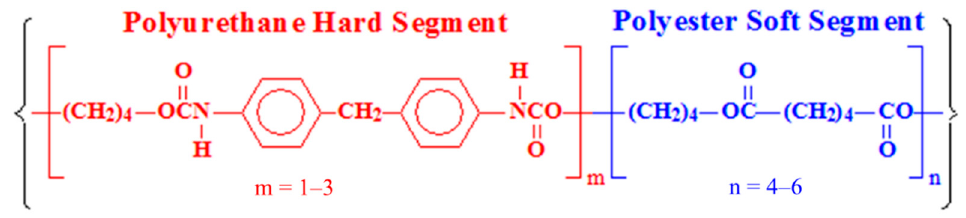
Figure 1. Molecular structure of Estane 5703.